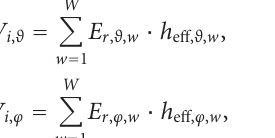
Figure 12: Signal wave path in a scattering environment. Transmit- ter and receiver dipole antennas in a DB scattering